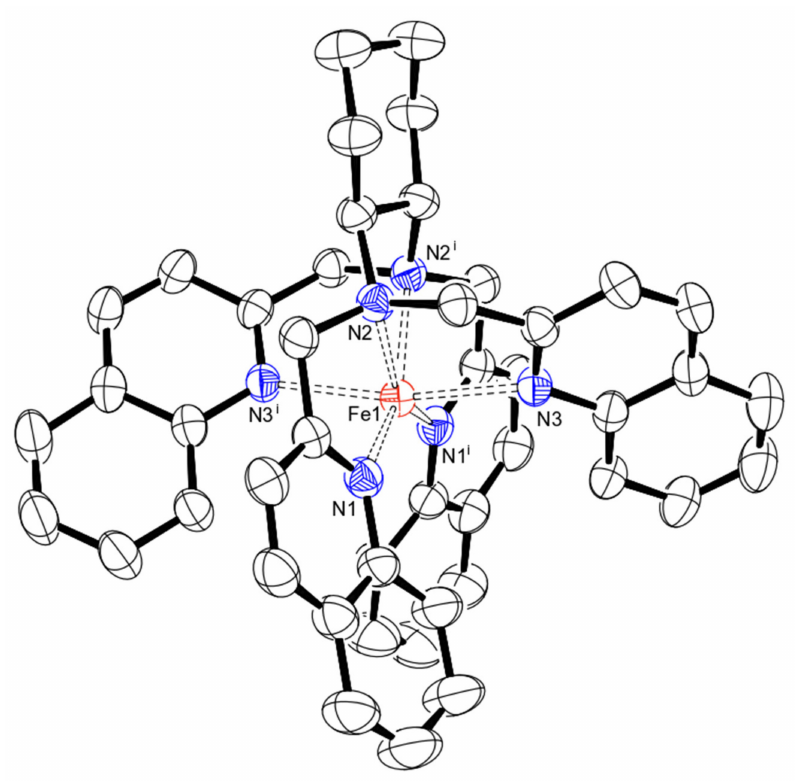
Figure 1. X-ray structure of Fe II ( ± CDA-BQA*)](CF 3 SO 3 ) 2 ( 5 ), showing a 30% probability of ther- mal